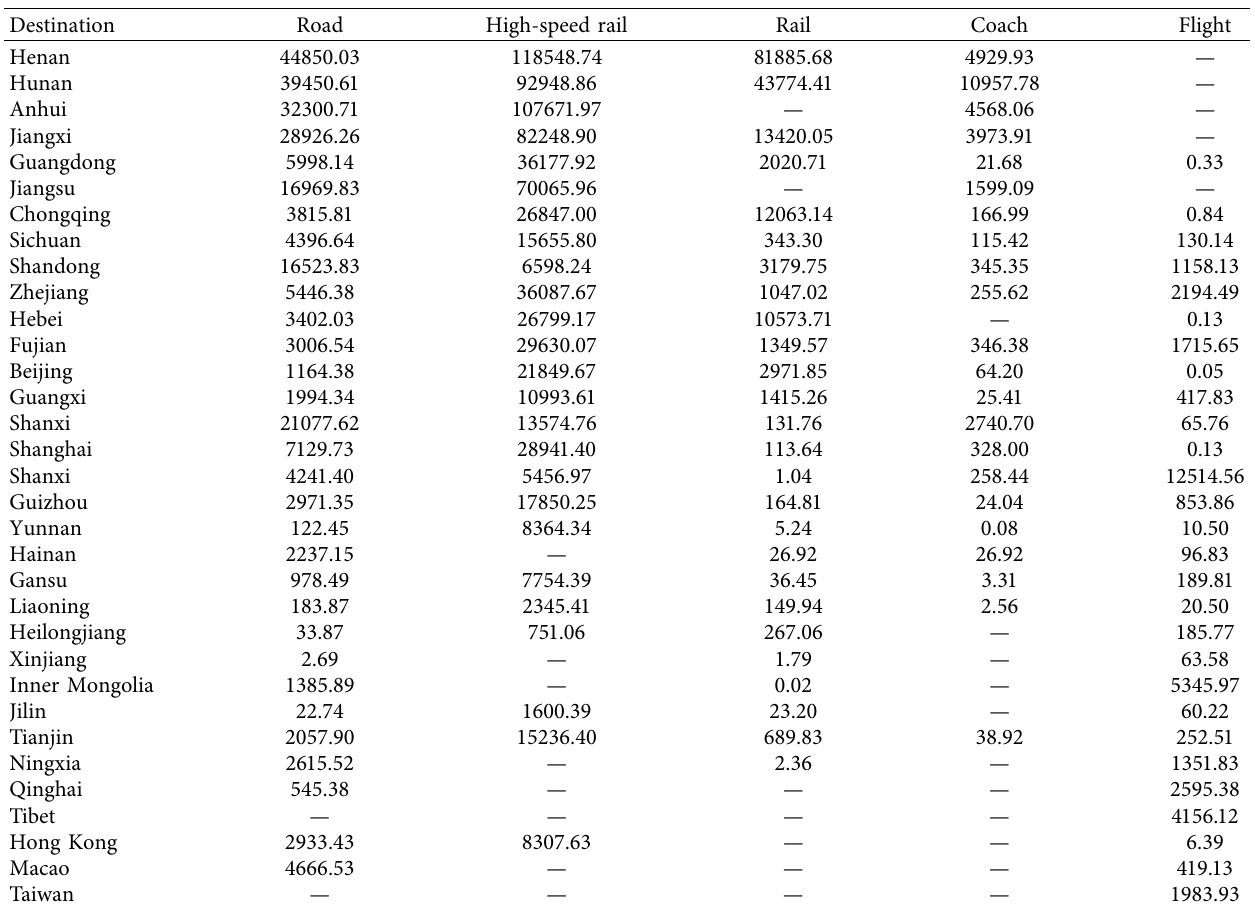
Table 12: Mode flow distribution results of other province-level destination regions outside the province of Hubei.